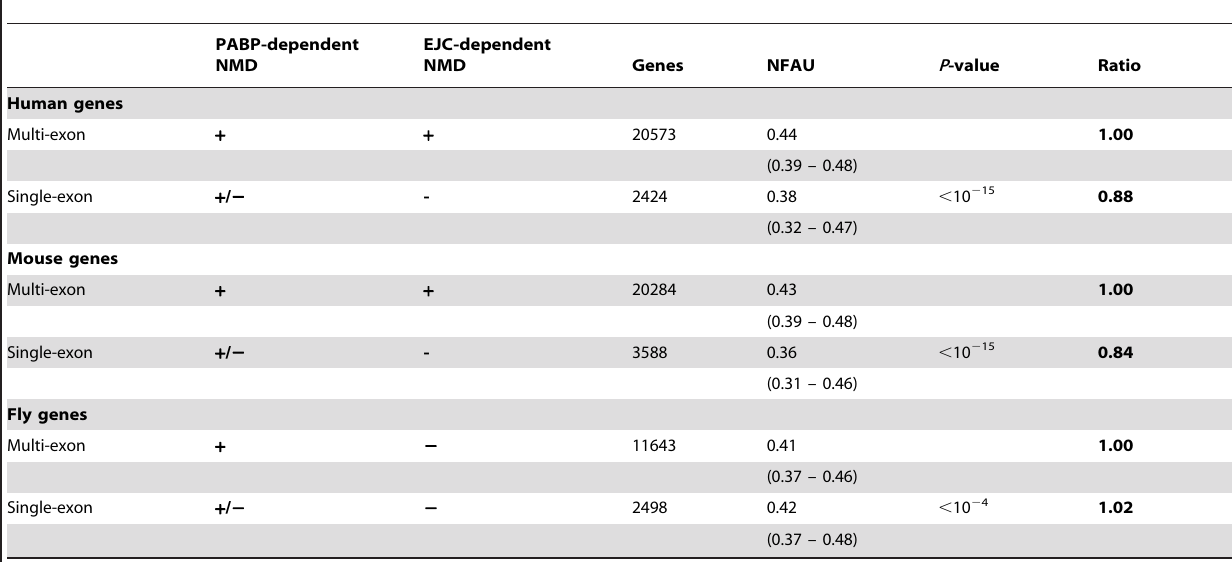
Table 3. Normalized fragile amino acid usage (NFAU) (controlling for GC-content) of proteins encoded by multi-exon genes and single-exon genes in the human, mouse, and fly